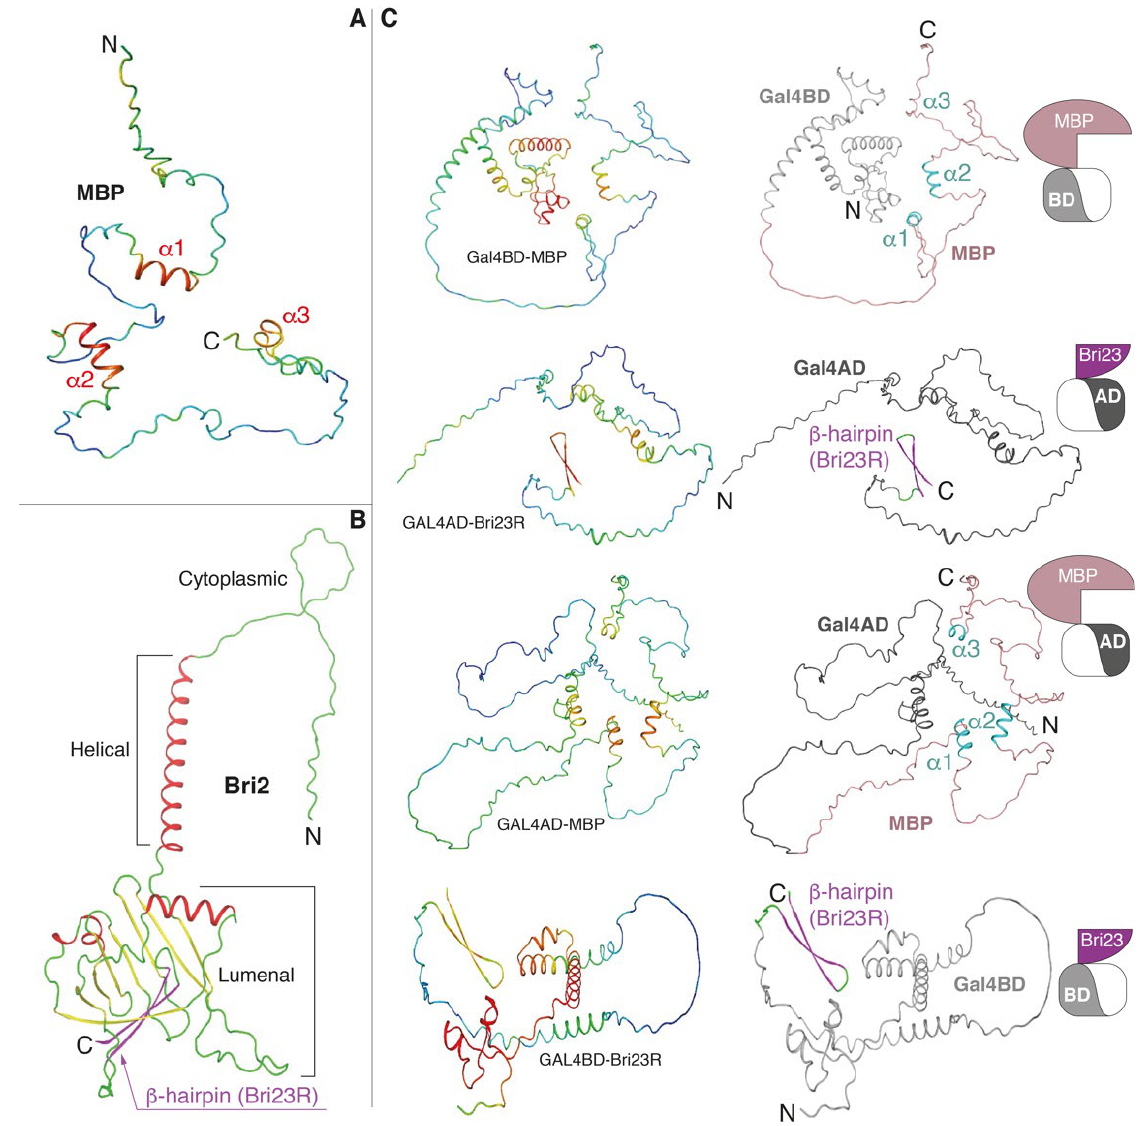
Figure 2. AlphaFold2-built 3D models. ( A ) MBP is colored according to the model confidence level: red—high confidence, blue—low confidence. ( B ) Bri2 is colored according to the secondary structure elements: coils, α -helices and β -strands are in green, red and yellow colors, respectively, with C-terminal β -hairpin (Bri23R) marked by magenta. ( C ) Fusion proteins, in which MBP and Bri23R were fused at the C-termini of Gal4BD and Gal4AD, respectively, or vice versa. Coloring is according to the model confidence (left panels) and domain organization (right panels): Gal4AD—dark gray, Gal4BD—light gray; in MBP, salmon and cyan colors correspond coils and α -helices, respectively; in Bri23R, magenta and green colors correspond β -strands and coils, respectively. See Table 1 and pictograms on the right side for illustration. Table 1. The description of the fusion proteins, which were used in the computational study.